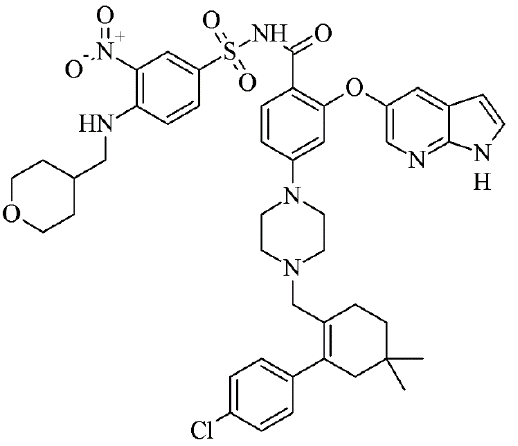
Figure 1. Chemical structure of venetoclax.